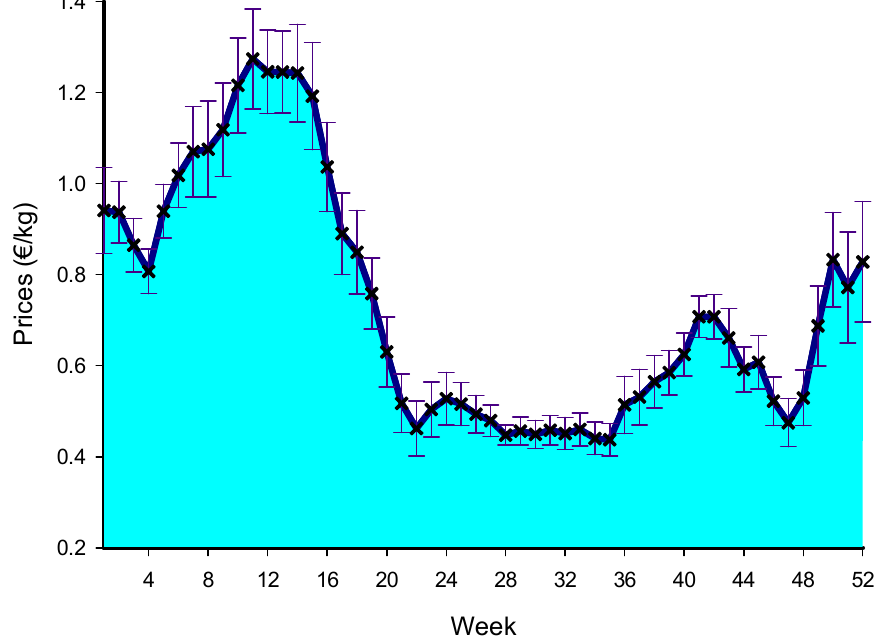
Figure 1. Evolution of mean weekly prices and standard error.